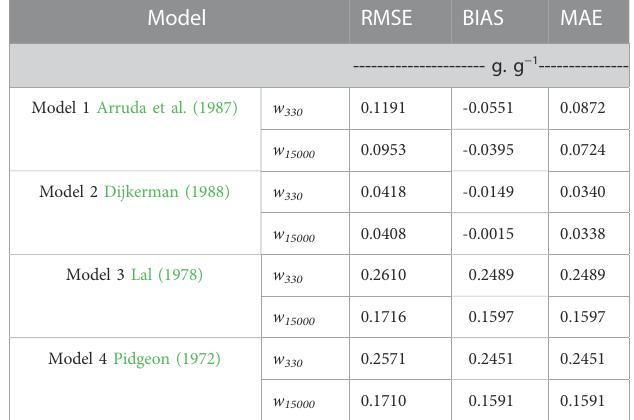
TABLE 4 Evaluation of the pedotransfer functions published using root mean square error (RMSE), BIAS, mean absolute error (MAE).